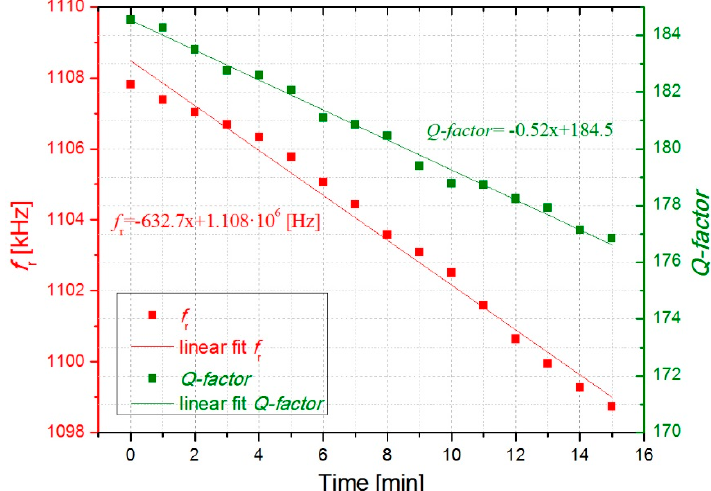
Figure 7. Open loop measurement showing the evolution of the resonant parameters with the deposition of cigarette particles for 15 minutes.